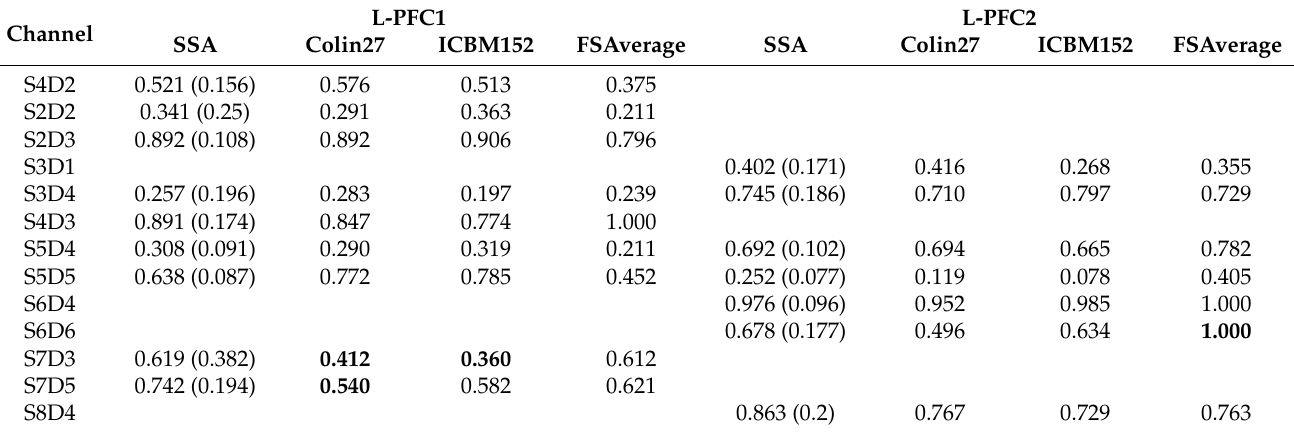
Table 11. Summary of A2Ch coefficients associated to selected left hemisphere functional ROIs: dorsolateral (PFC1) and ventrolateral prefrontal cortex (PFC2). Results are reported for wavelength λ = 760 nm. Bold ABA values indicate channels presenting a 20% difference in A2Ch coefficients from the SSA median.